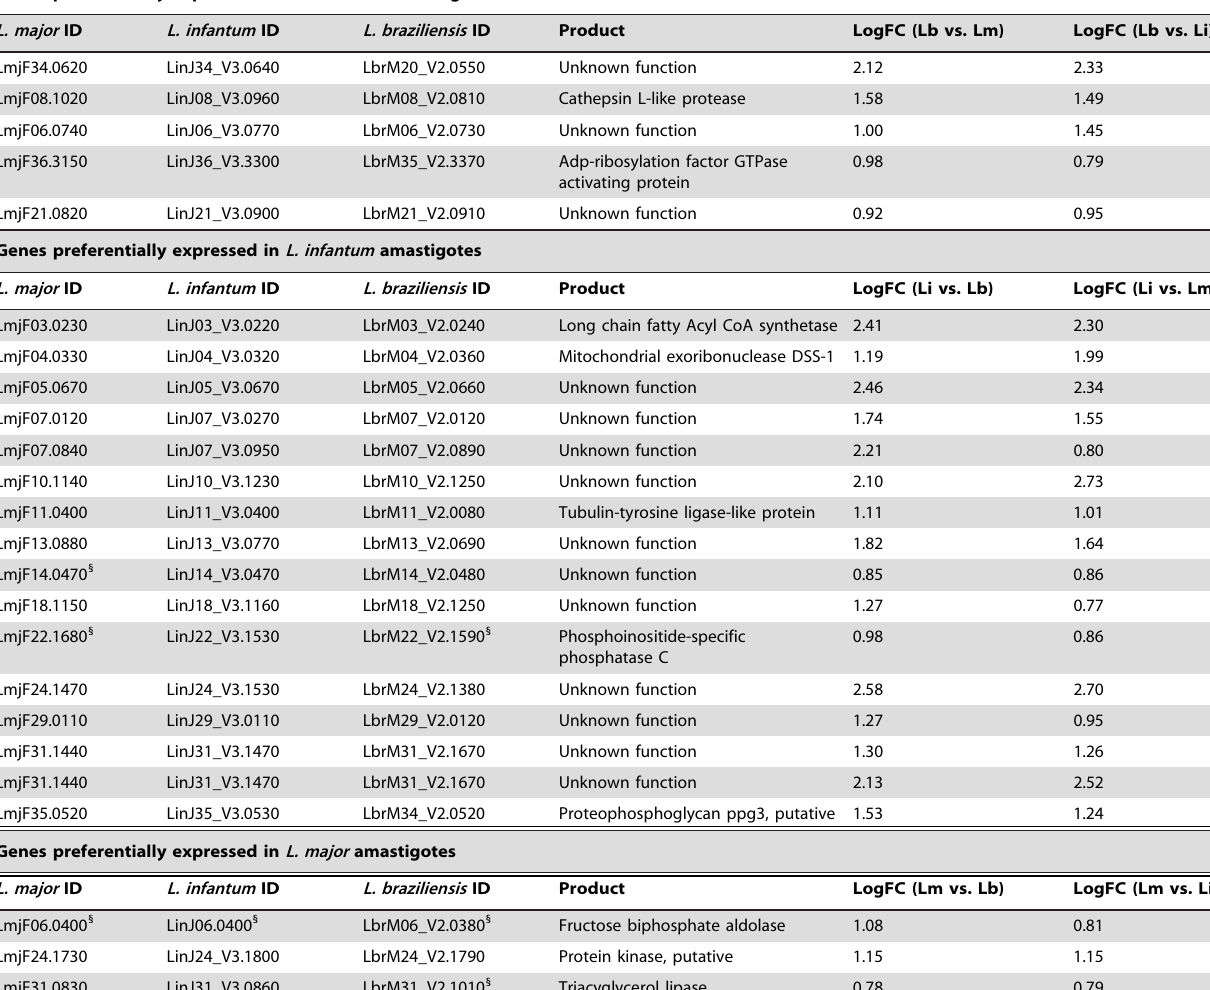
Table 3. Conserved genes preferentially expressed in